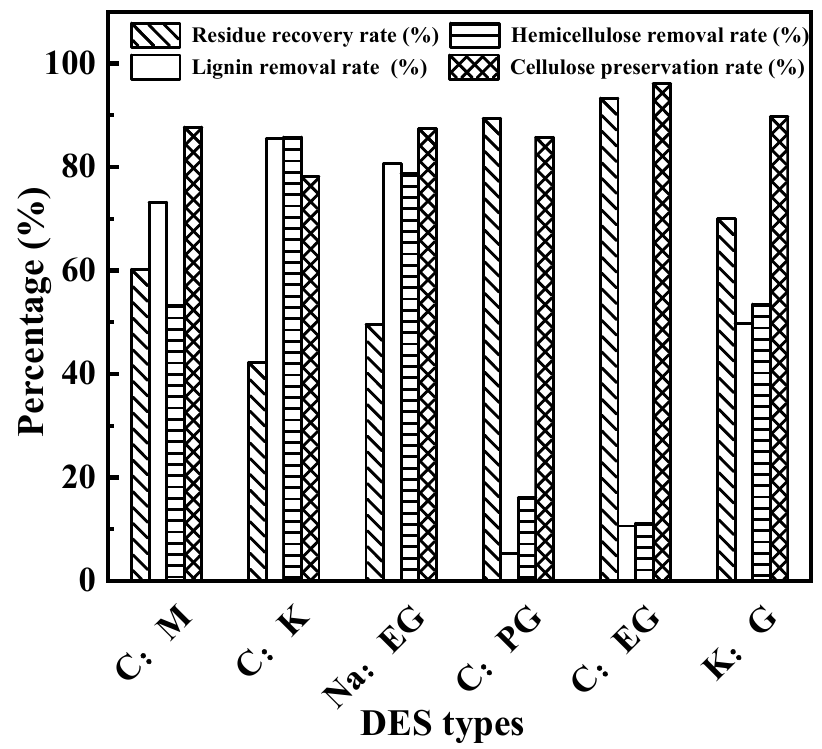
Figure 1. Enhancement of enzymatic hydrolysis of wheat straw with di ff erent DESs.